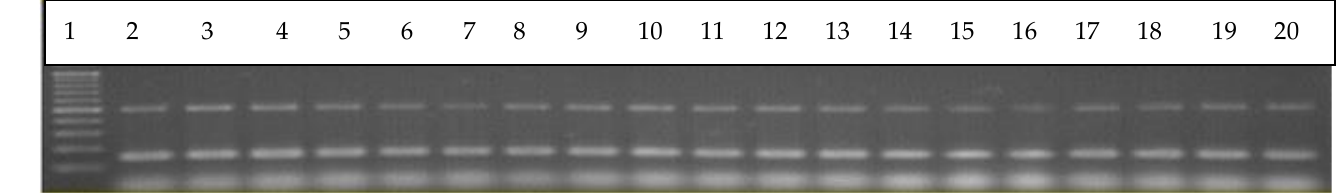
Figure 1. Multiplex PCR of vicK and vir R genes (TCS VicKR) for randomly selected S. mutans clinical isolates. Size of the products: vicK -510 bp, vir R -211 bp. 1, size standard; 2, S. mutans UA 159 positive control; 3–11, clinical isolates from adults; 12–20, isolates from children.